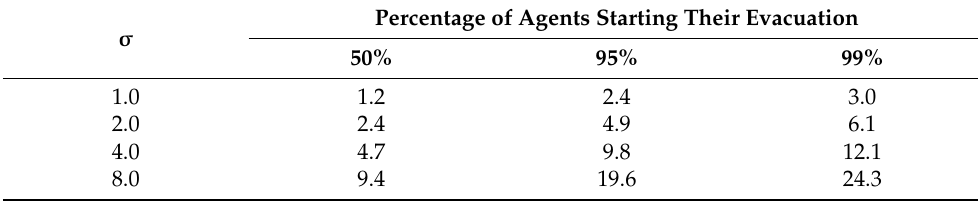
Table 2. Required time (min) for agents to initiate an action as a function of σ ( τ = 0). Percentage of Agents Starting Their σ